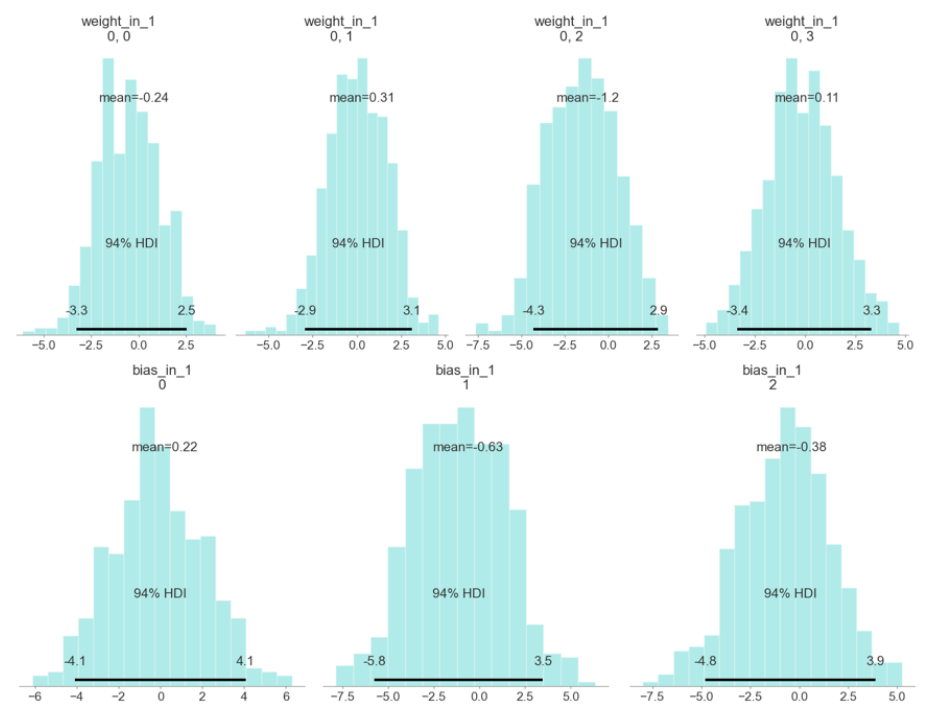
Figure 10. Trained weights and bias at links that connect input layer to the first hidden layer for tsunami in 1983.